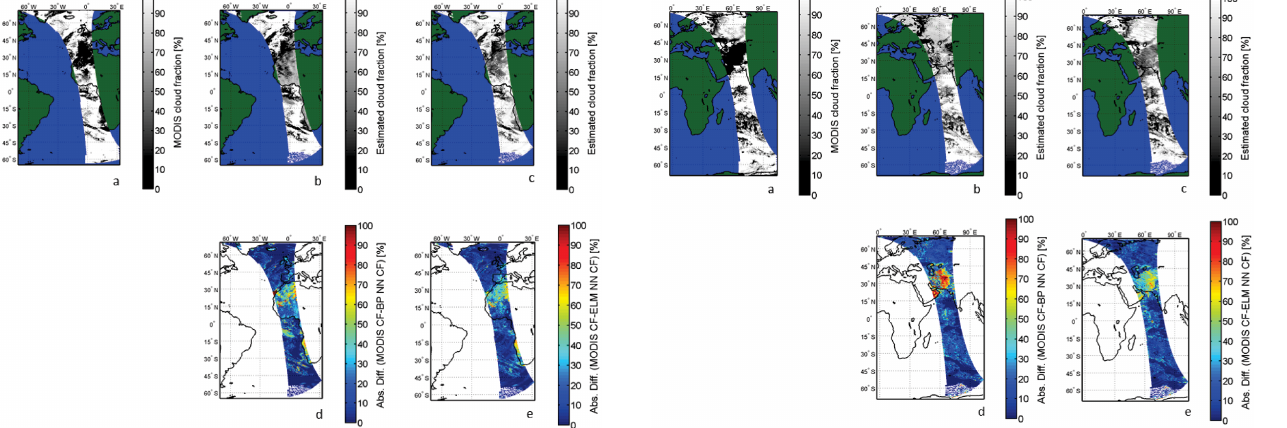
Fig. 6. Cloud fractions estimated by the BP and ELM-trained NN and comparison with MODIS CF data for the validation orbit 2005m0828t1257. (a) Computed MODIS geometrical cloud frac- tion re-located onto the OMI grid. (b) BP predicted cloud frac- tion. (c) ELM predicted cloud fraction The grey-code in figures a-c ranges from 0 (cloud free) to 100 (totally cloud covered). (d) Ab- solute difference between MODIS geometrical cloud fraction and BP-predicted cloud fraction. The color-code ranges from 0 (per- fect match) to 100 (complete mismatch). (e) Absolute difference be- tween MODIS geometrical cloud fraction and ELM-predicted cloud fraction. The color-code in panels (d) and (e) range from 0 (perfect match) to 100 (complete mismatch)